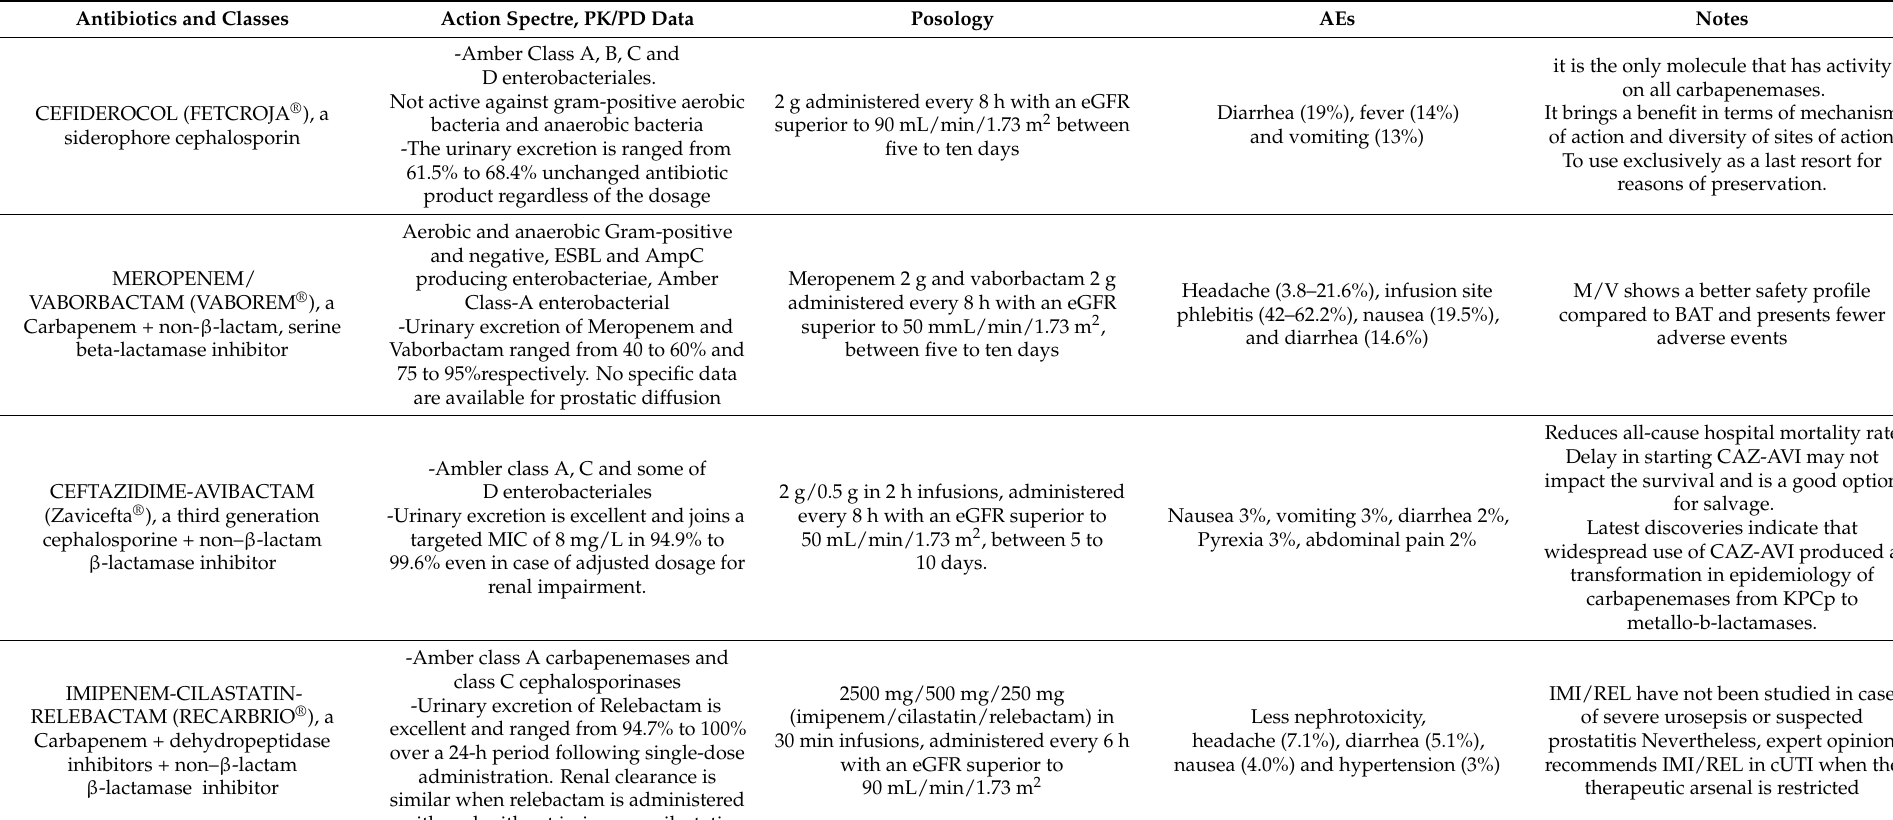
Table 2. Summaries of main characteristics of these new antibiotic drugs and their efficacy on KPCp